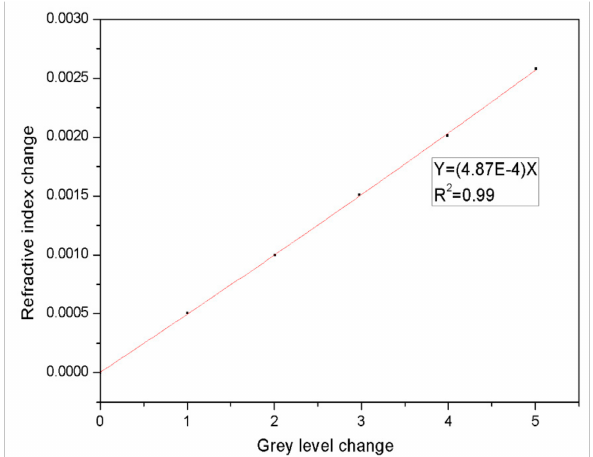
Figure 15. Relationship between the change in refractive index and the change in grey level in the PSi microcavity.